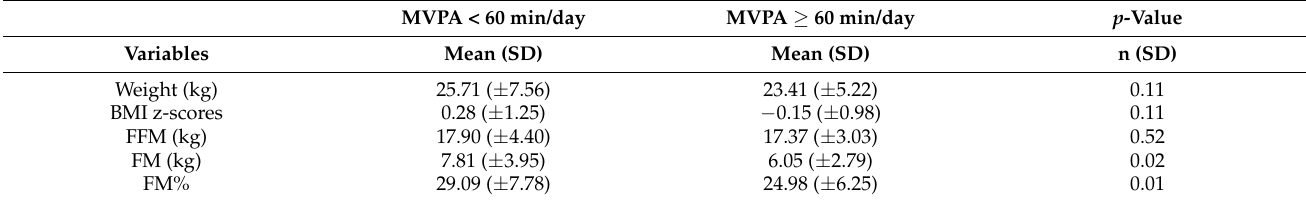
Table 3. Descriptive characteristics of participants according to the moderate-to-vigorous physical activity